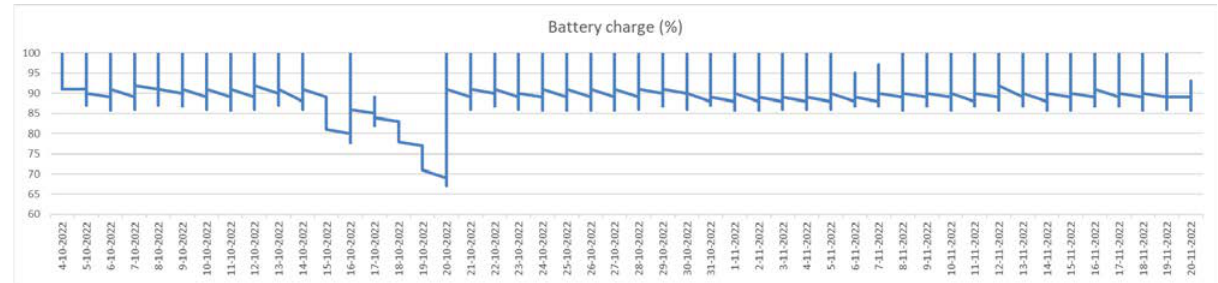
Figure 6. Daily balance of power consumption using a 20W solar panel. Note, the sufficiency of the power-supply scheme, even in winter time, for hourly emissions of data.